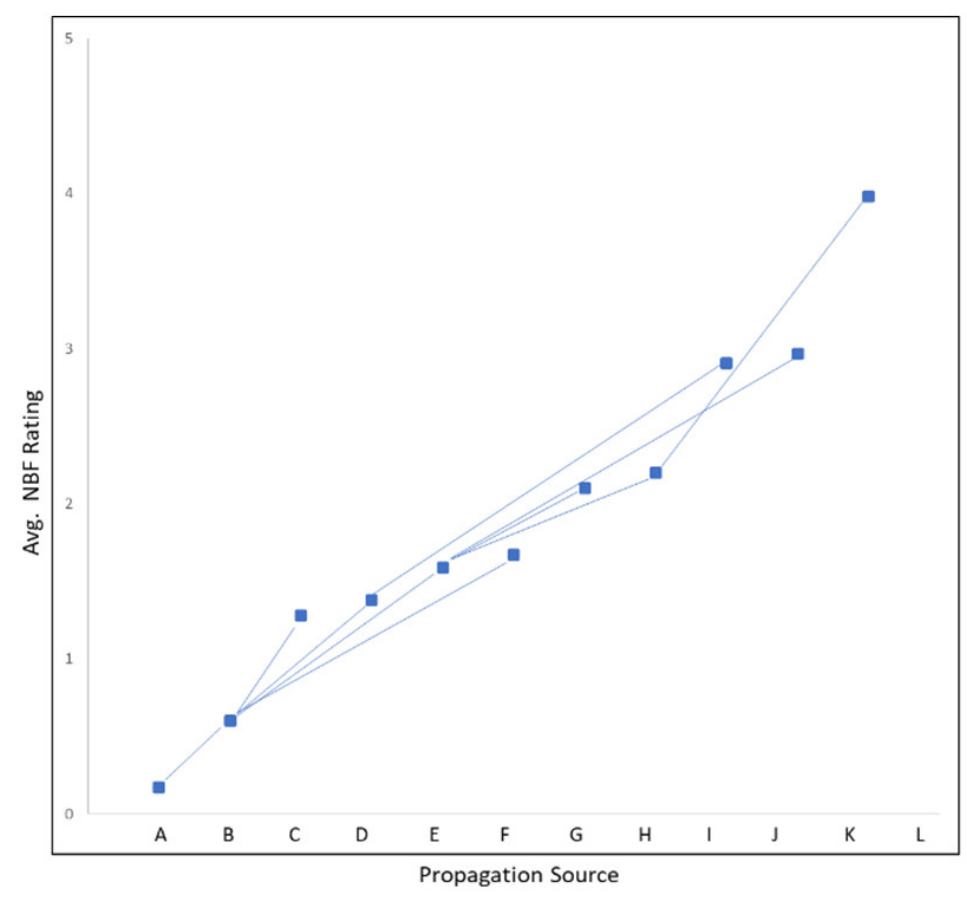
Figure 2. Average noninfectious bud-failure (NBF) expression for the different nursery propagation sources of ‘Carmel’ almond with the relatedness or dissemination lineage of propagation sources plotted based on available propagation records. (The letter A identifies the original breeder seedling tree while B through L identify different commercial nursery propagation sources).